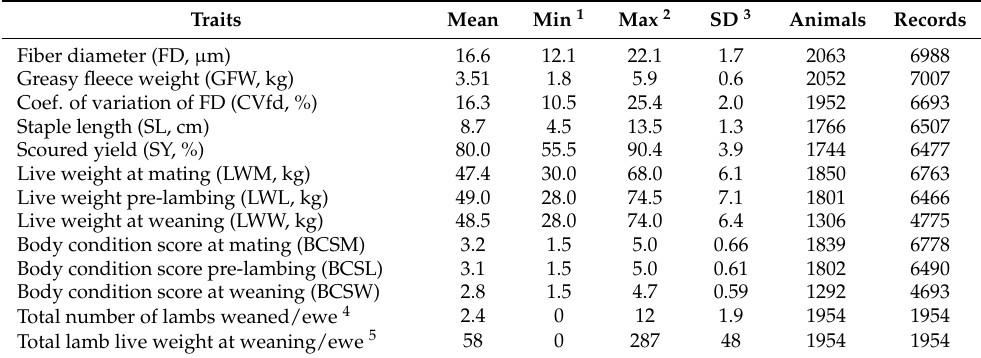
Table 2. Ewe annual mean, standard deviation (SD), and number of records of the fiber diameter (FD, µ m), greasy fleece weight at shearing (GFW, kg), and live weight at mating (LWM, kg) (1999–2020).